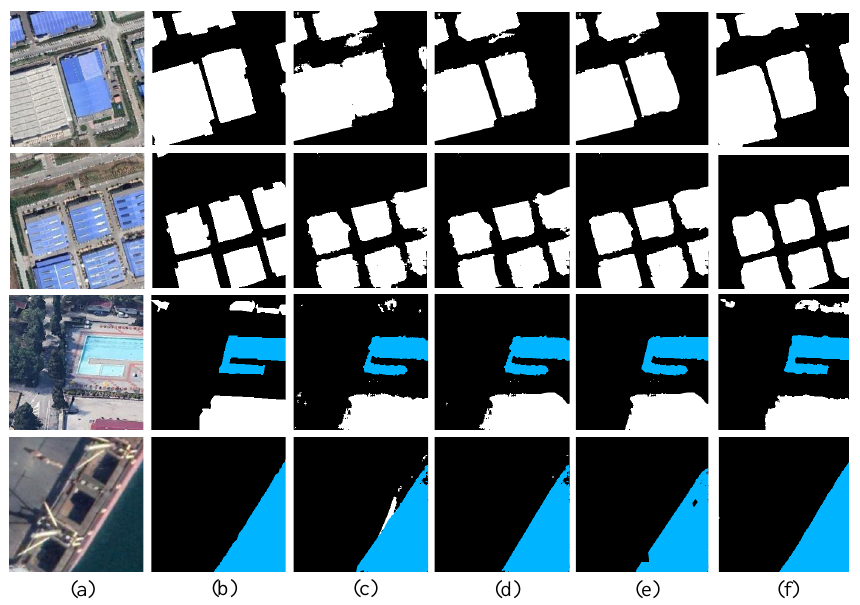
Figure 10. Diagram of the effects in the ablation experiment.( a ) Real image; ( b ) label; ( c ) SFR; ( d ) SFR + LIU; ( e ) SFR + EFA; ( f )